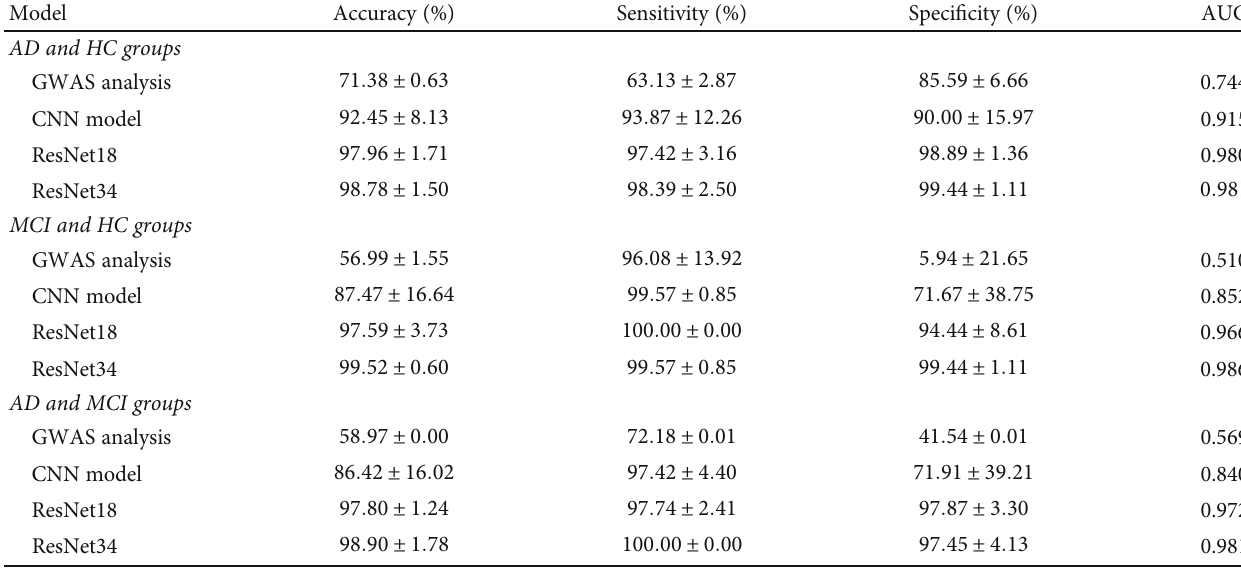
Table 3: Performance of di ff erent classi fi cation approaches in multitasking classi fi